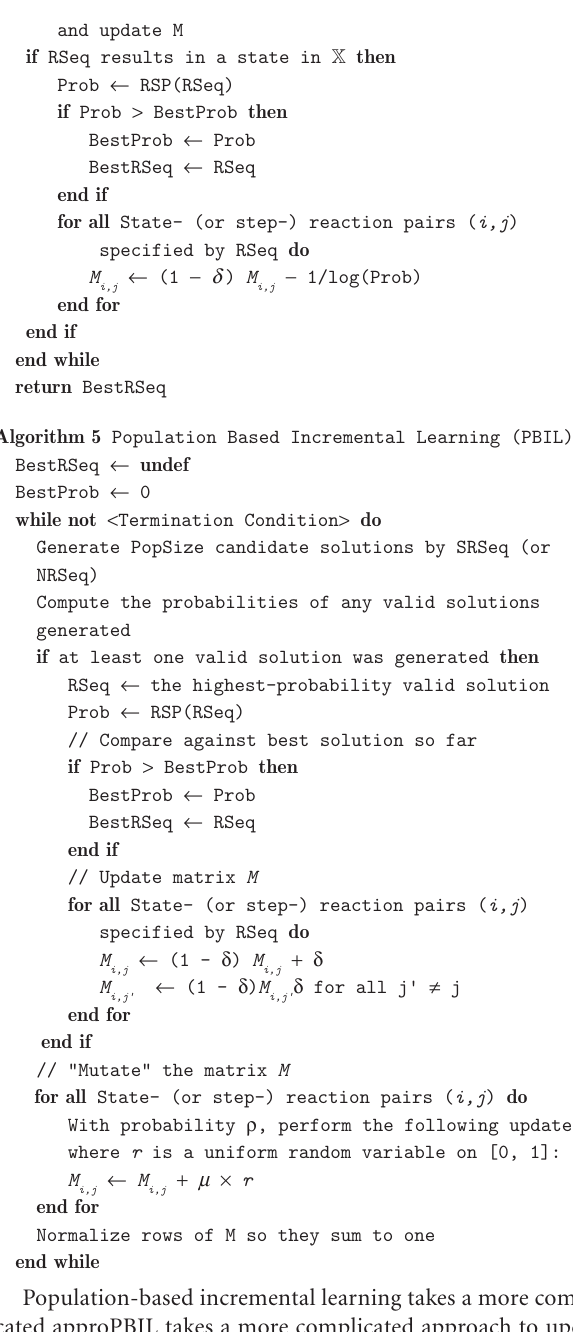
Algorithm 5 Population Based Incremental Learning